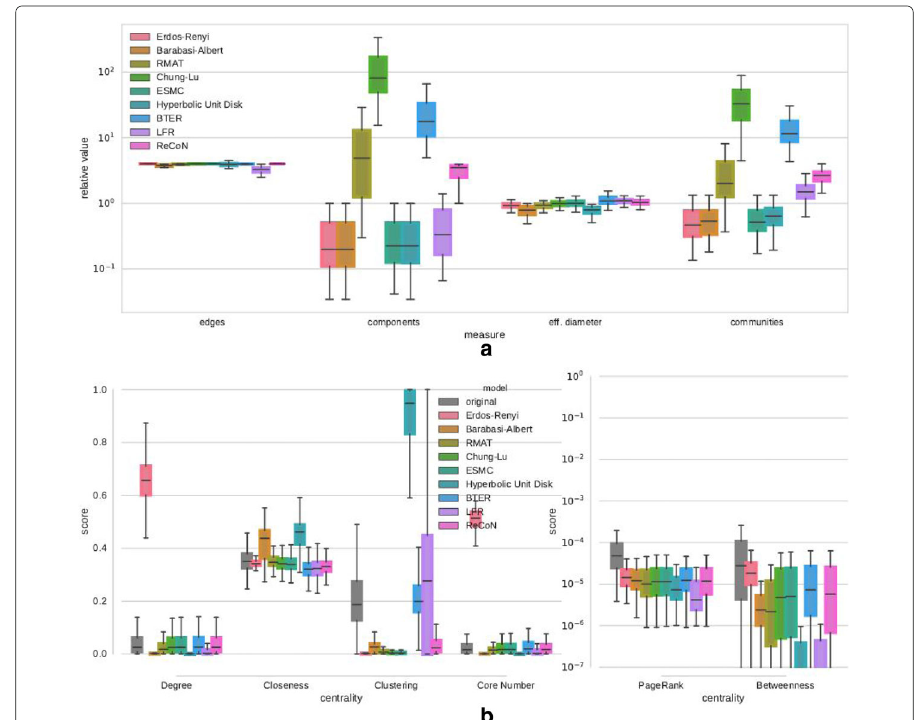
Fig. 11 Structure replication of Facebook networks with scaling factor 4. a Relative deviation of scalar network properties, b Distribution of centrality scores